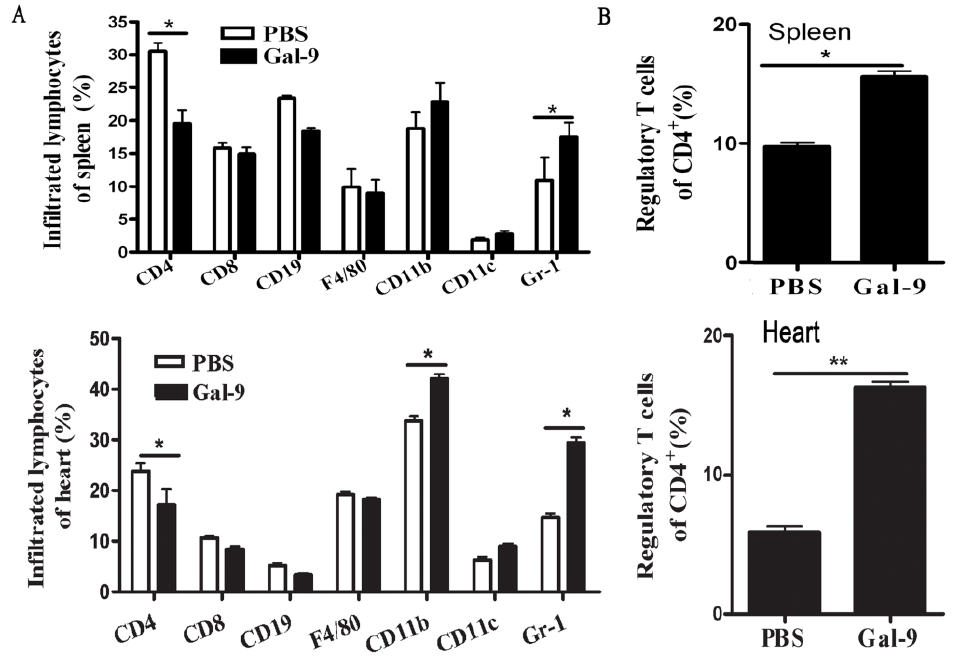
Figure 2. Influence of galectin-9 on cellular immune response during CVB3 infection. BALB/c male mice were infected with CVB3 on day 0 and received recombinant galectin-9 (100 μg/mL, n = 8) or PBS ( n = 8) IP daily from day 3 to day 7. Then the splenocytes and the heart-infiltrated cells were isolated on day 7 after enzymatic digestion and analyzed for CD4, CD8, CD11b, CD11c, CD19, F4/80 and regulatory T cells by FACS. A statistically significant difference in these groups is indicated ( A and B ). Similar results were obtained in three separate experiments. Data show the mean ± SEM. * , p < 0.05; ** , p < 0.01.